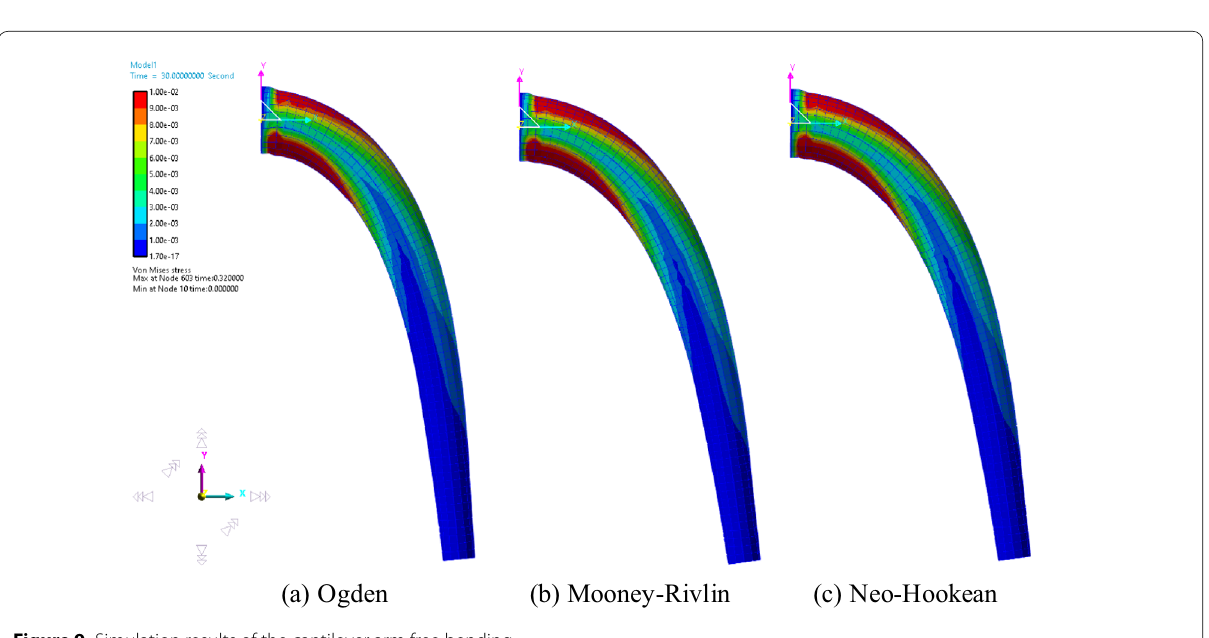
Figure 9 Simulation results of the cantilever arm free